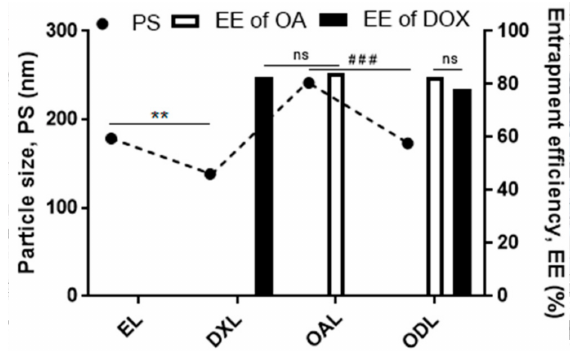
Figure 2. Particle size and EE variation after active loading of DOX at 60 ◦ C. A significant changes were observed in particle sizes of EL and OA loaded liposome (OAL) ( p < 0.01 (**) and p < 0.001 (###), respectively), before and after loading of DOX, while no significant change (ns) was observed in the EE of OA. Similarly, no significant change in EE was observed in the individual loading of both drugs in the